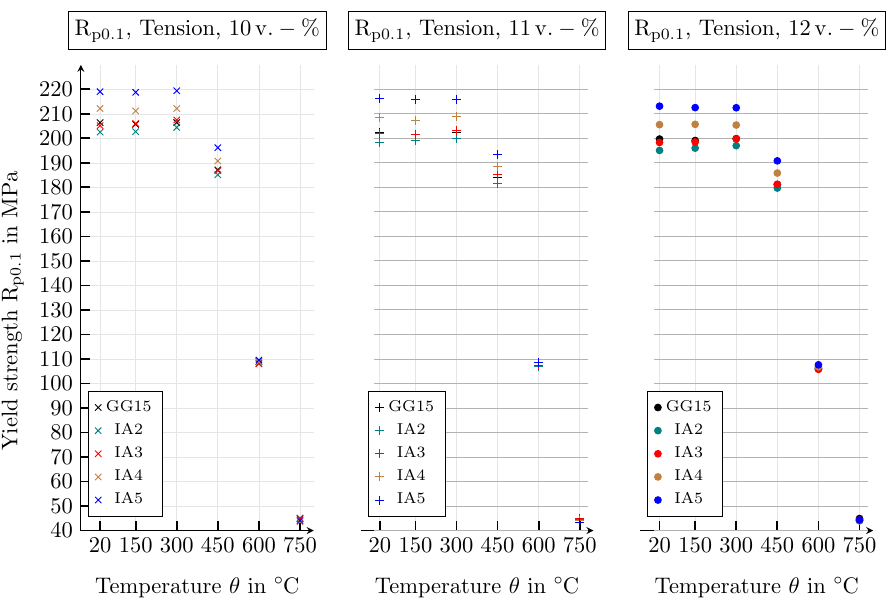
Figure 26. Yield strengths of all graphite classes with graphite flake volume fractions of 10, 11 and 12v. %, evaluated for the temperatures 20, 150, 300, 450, 600 and 750°C, at a tensile strain of ε = − 0.1%.